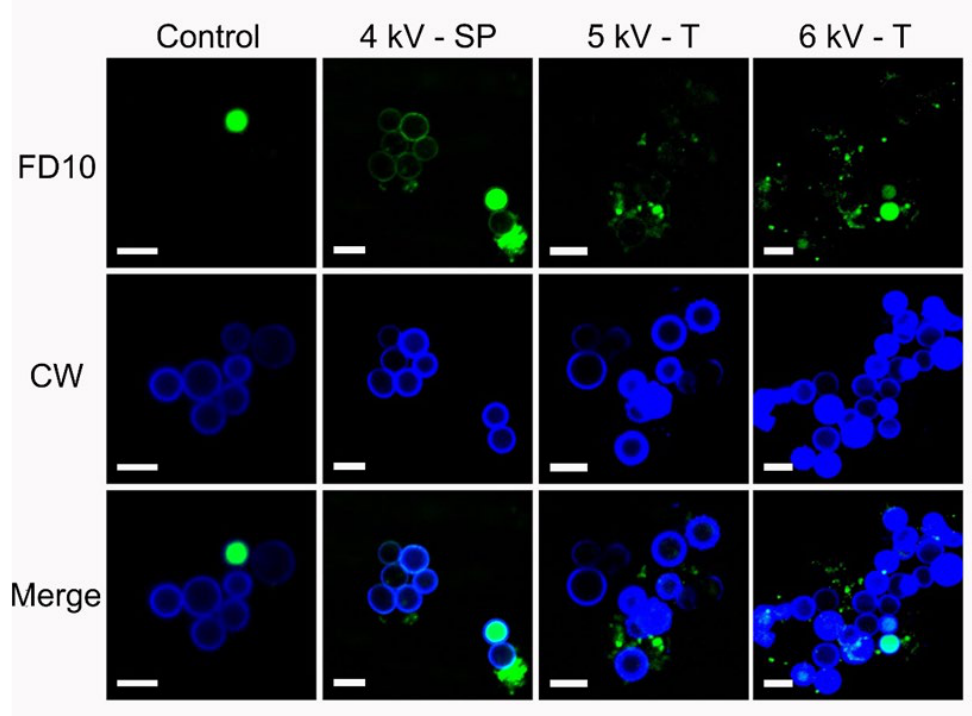
Figure 6. Confocal microscopy images showing the permeabilization of Aspergillus niger conidia after exposure to 200 single-pulse shock waves (SP) generated at 4 kV, and 200 tandem shock waves (T) generated at 5 and 6 kV. Representative images of nontreated cells are shown in the first column (Control). FD10 was assessed with merge fluorescence of calcofluor white dye. Scale bar: 5 μm.